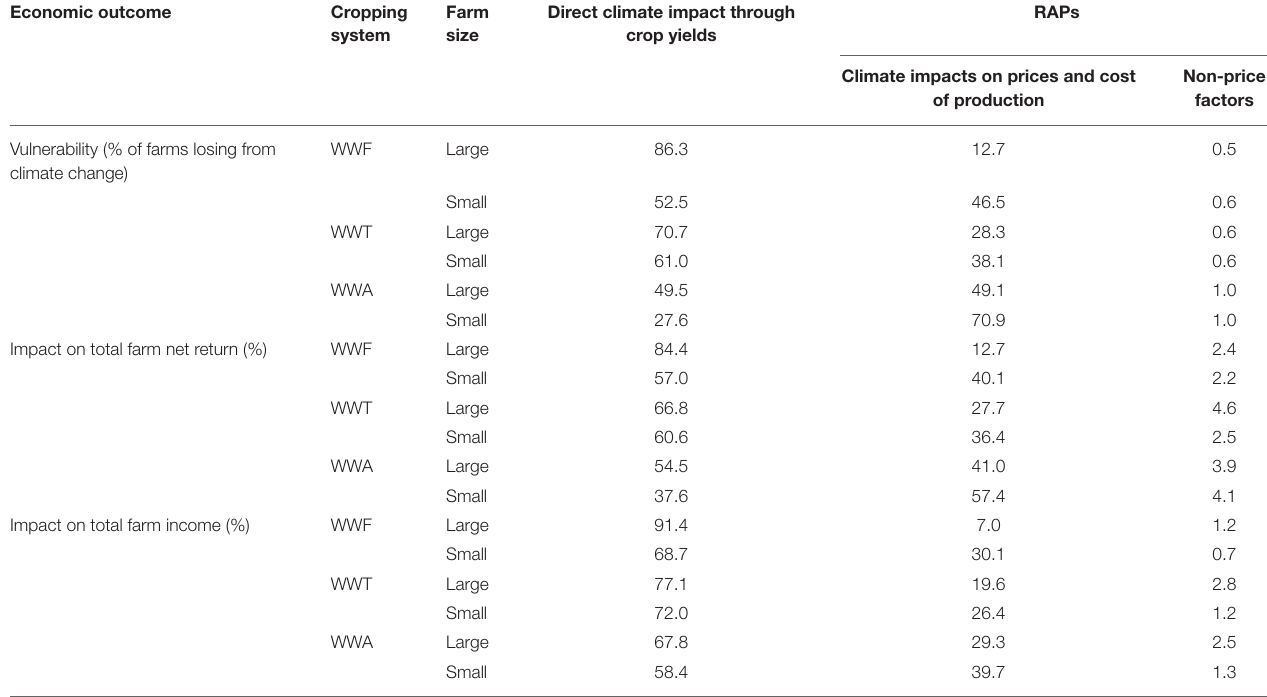
Farm Direct climate impact through system size crop yields